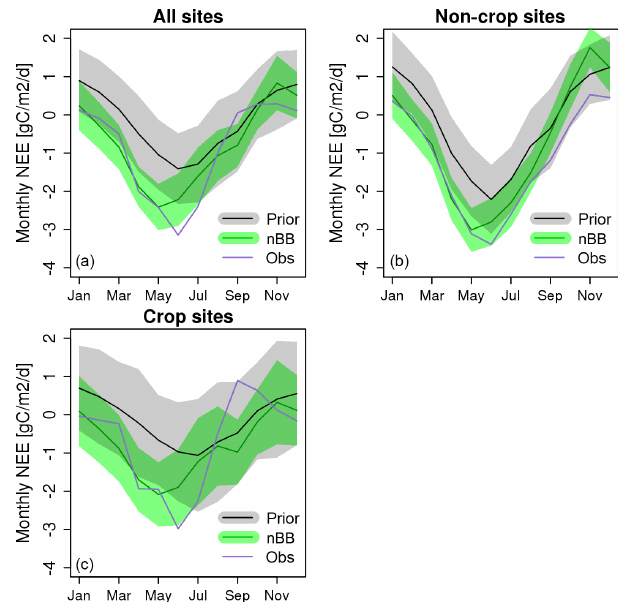
Figure 7. Temporal evolution of monthly NEE (gCm − 2 day − 1 ) av- eraged over all EC sites (a) , excluding crop sites (b) and using only crop sites (c) . Uncertainties (error of the mean monthly NEE) are indicated by the shaded areas.